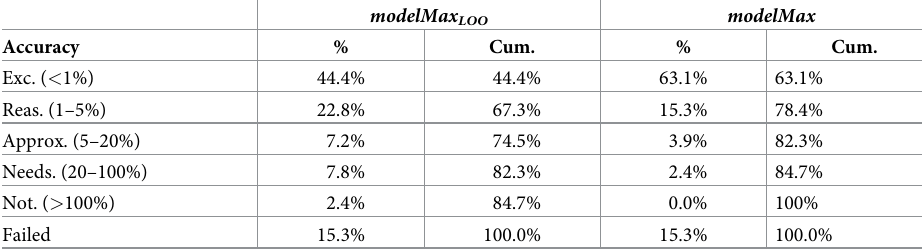
Table 3. Accuracy result metrics from the automated georeferencing of real-world country-maps.